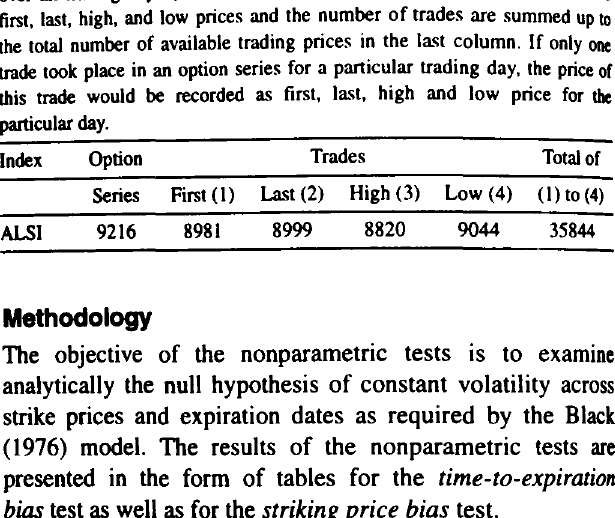
Table 1 Data categorised into trading classes The data is reported for the ALSI after screening for arbitrage violations and mistake trades in the period 16 October 1992 to 31 Decef!lber